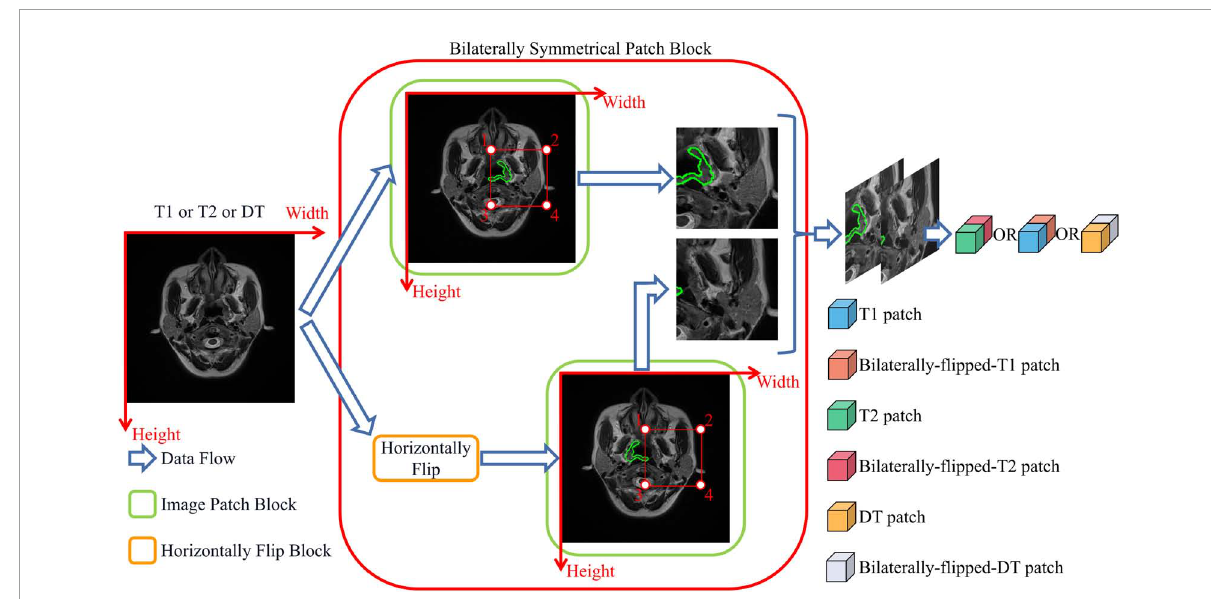
FIGURE2 Bilaterally symmetrical patch block. The bilaterally symmetrical patch block crops the images and their horizontally flipped images into patches of the same size. Bilaterally flipped images are treated as an independent modality.